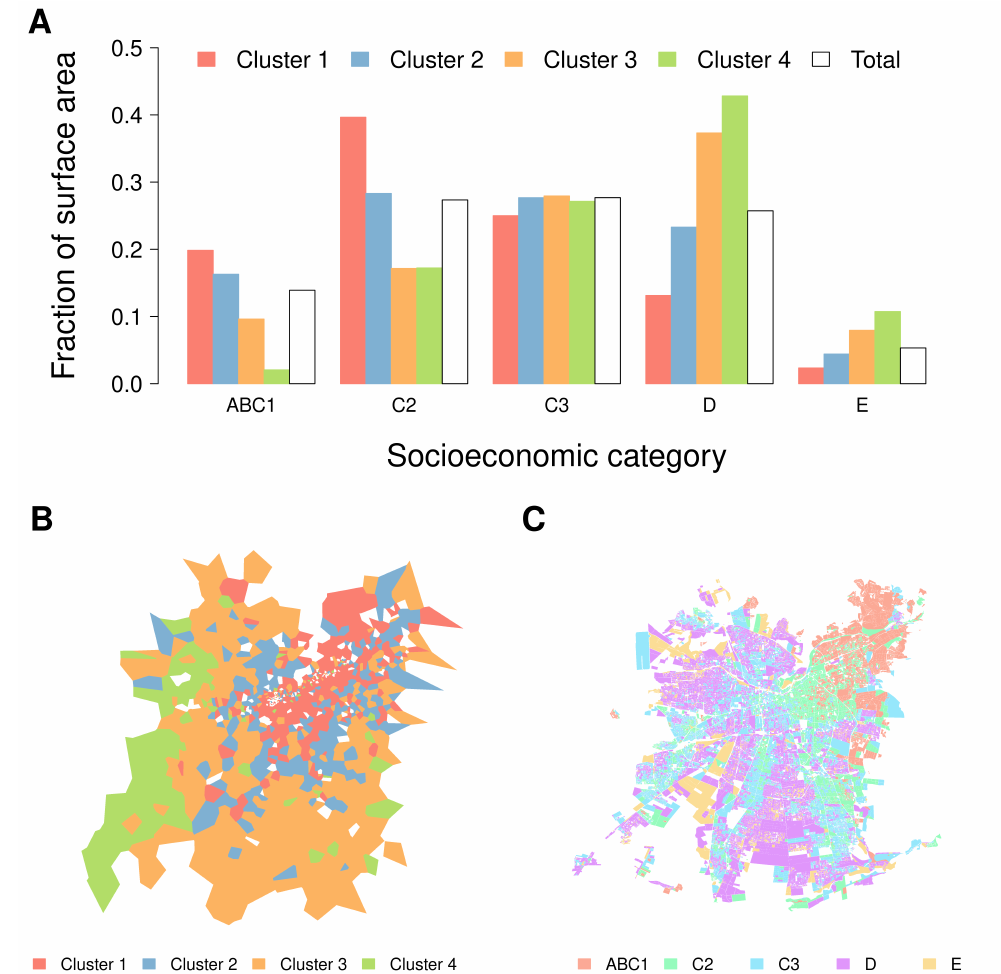
Figure 2. Socioeconomic characteristic of the clusters. ( A ) Fraction of surface area dedicated to each socioeconomic category according to the cluster (colored bars) and in total (white bar) for the whole country. ( B ) Maps of the four clusters in Gran Santiago (the largest city). ( C ) Spatial distribution of socioeconomic categories in Gran Santiago (the largest